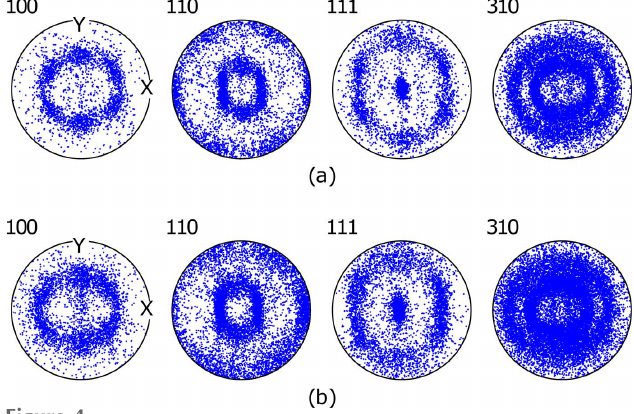
Figure 4 Pole figures with orientations plotted from ( a ) EBSD and ( b ) 3DXRD, demonstrating that each method conveys a matching texture.